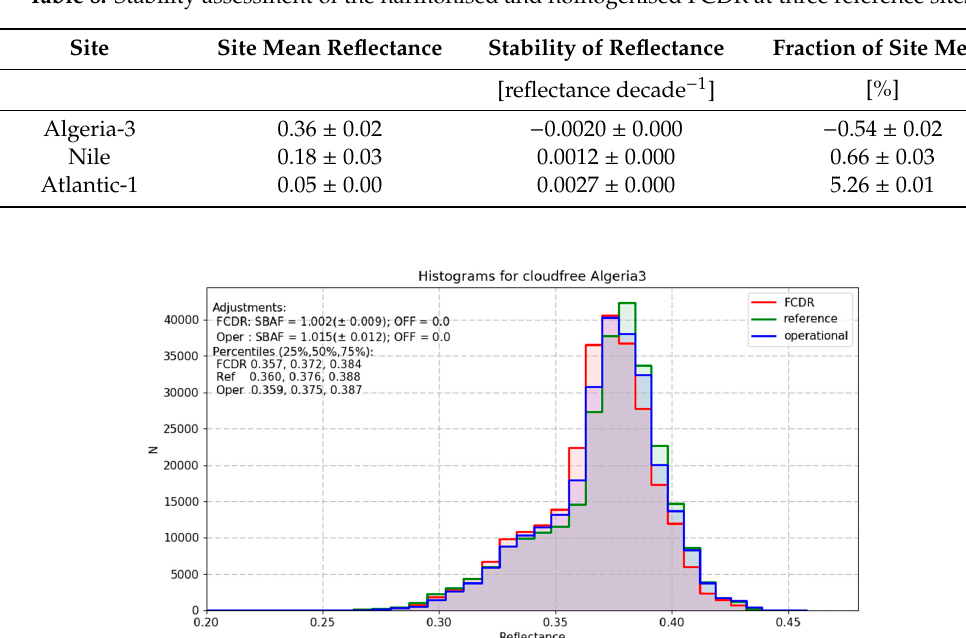
Table 8. Stability assessment of the harmonised and homogenised FCDR at three reference sites.